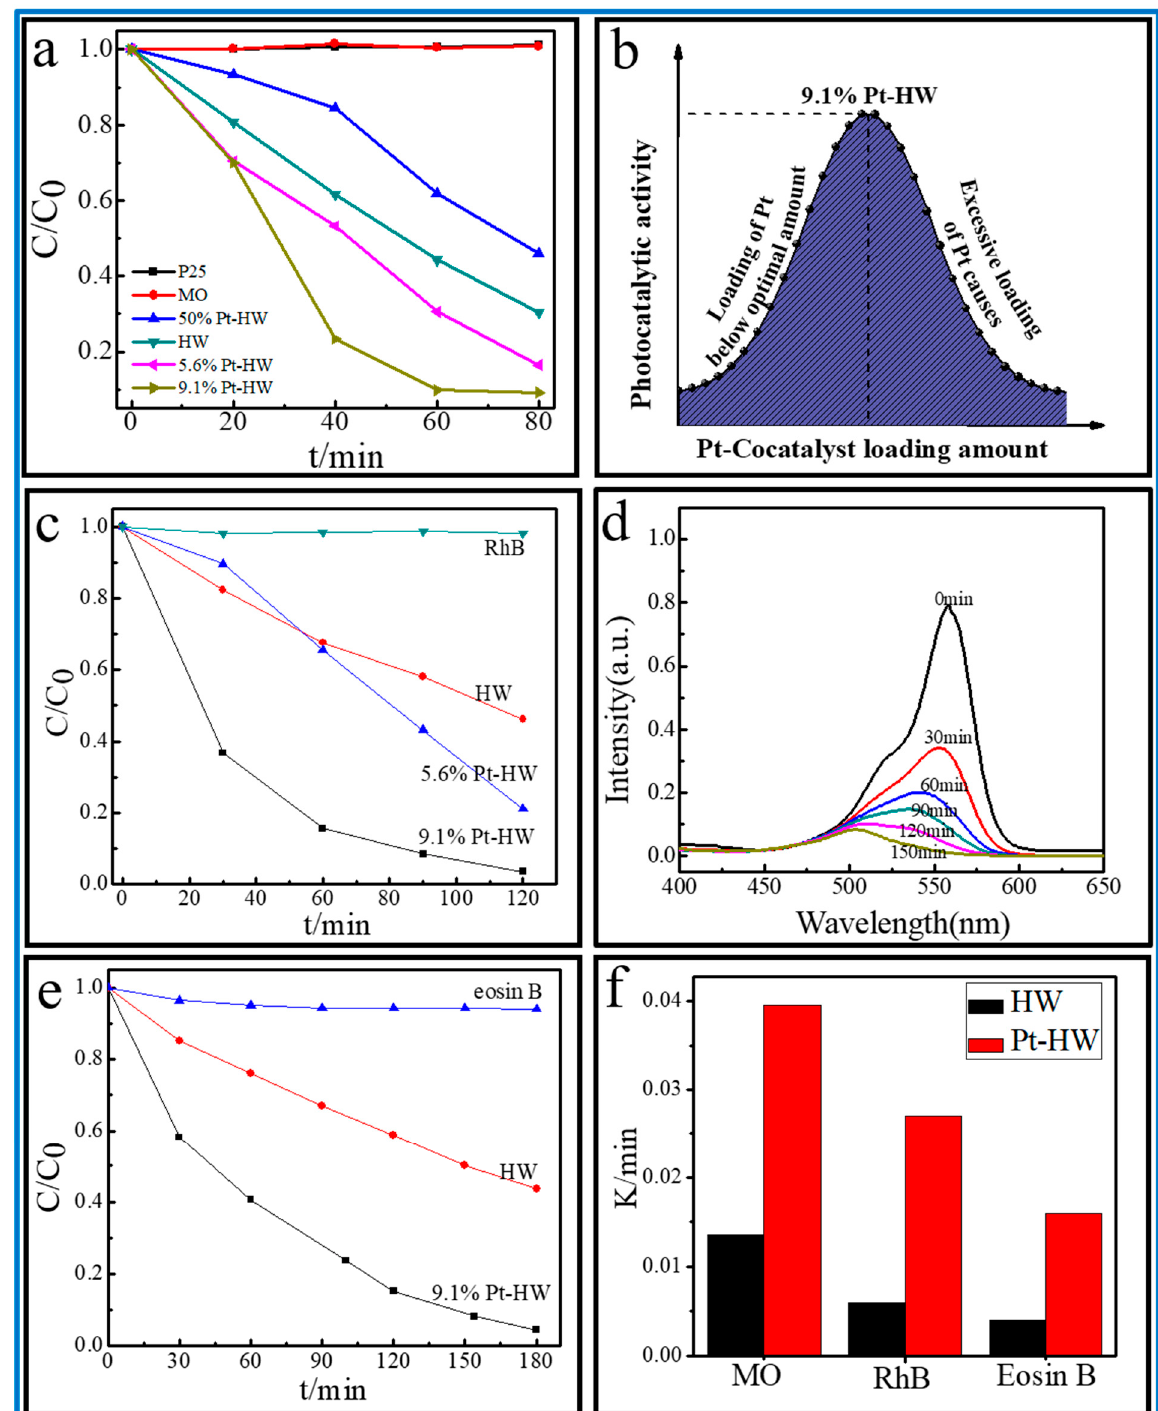
Figure 5. ( a ) MO degradation curves of Pt-HW with different Pt loadings; ( b ) degradation MO rate constant fitting map of Pt-HW with different Pt loading; ( c ) RhB degradation curve of Pt-HW; ( d ) UV–Vis absorption spectral changes for RhB as a function of irradiation time in the presence of 9.1% Pt-HW; ( e ) eosin B degradation curve of Pt-HW. ( f ) The comparison of photodegradation rate constant of different dyes using Pt-HW and HW.